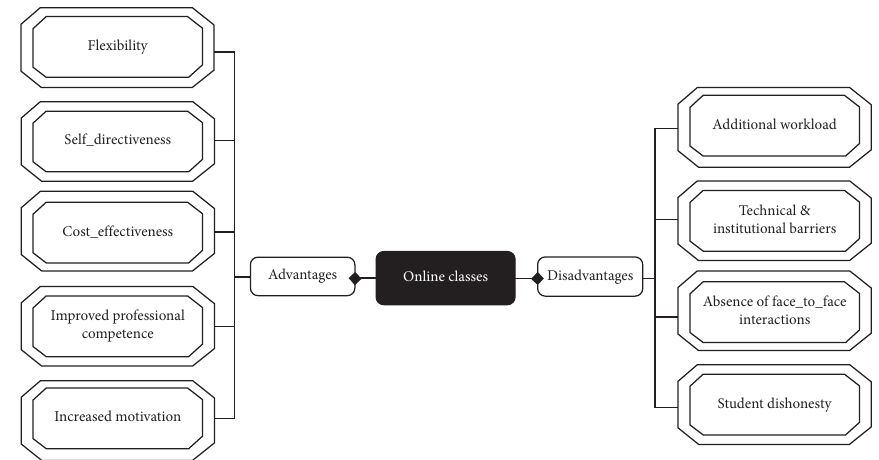
Figure 1: A model of advantages and disadvantages of